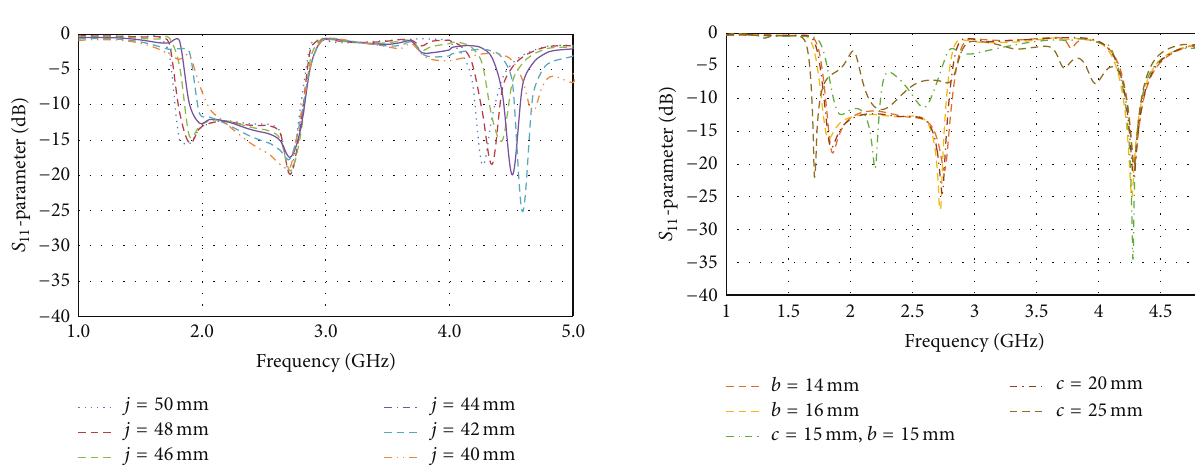
Figure 3: Return loss response for change in the value of “ 𝑗 .”